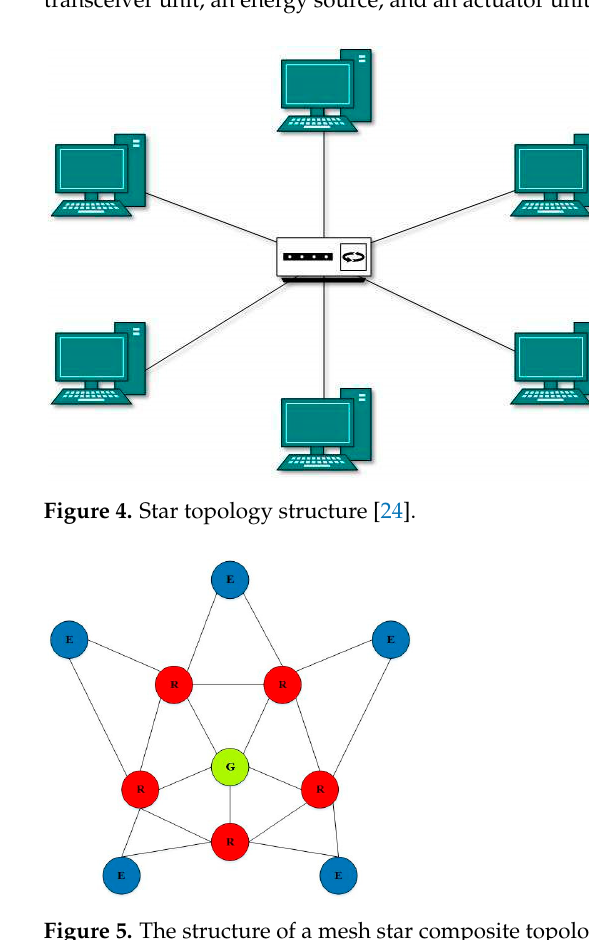
Figure 5. The structure of a mesh star composite topology in which nodes are connected to a central node [24].